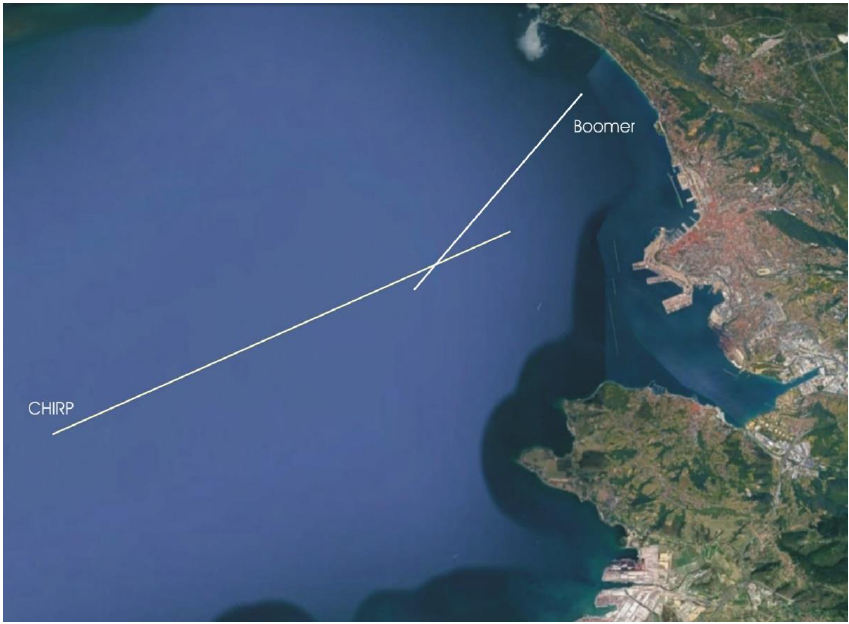
Figure 8. Location map of two intersecting profiles at the Gulf of Trieste (northern Adriatic Sea): one acquired by a Chirp system, the other with a Boomer system.